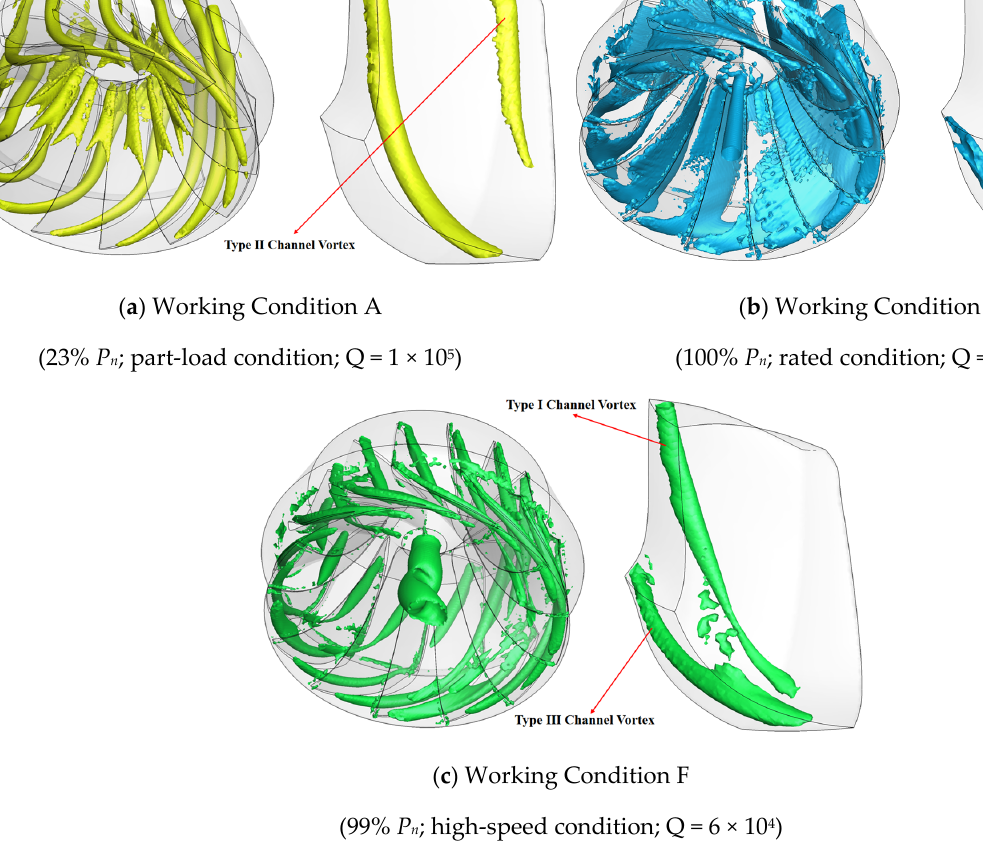
Figure 8. Structure of channel vortex captured by Q criterion. Note: ( a – c ) describe channel vortex structures captured by Q criterion.